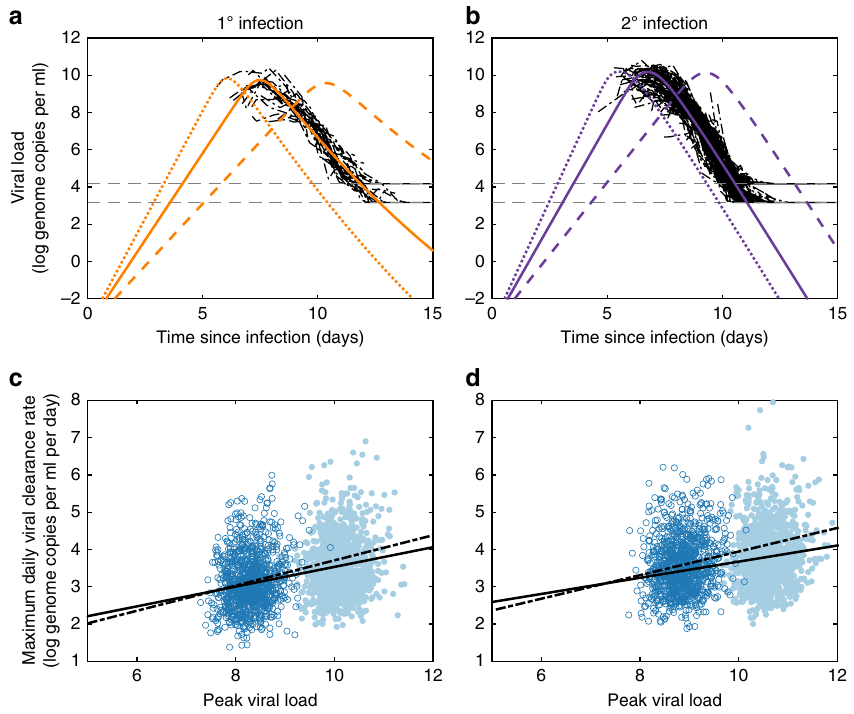
Fig. 2 Within-host model dynamics reproduce empirically observed peak viral load-clearance rate trade-off. a , b Model-simulated viral load dynamics alongside viremia measurements from individuals experiencing a a primary dengue infection and b a secondary dengue infection. Solid colored lines show viral load dynamics parameterized with the mean estimated viral infectivity rate. Dotted lines show viral load dynamics parameterized with a viral infectivity rate two standard deviations above the estimated mean. Dashed lines show viral load dynamics parameterized with a viral infectivity rate two standard deviations below the estimated mean. Viremia measurements are shown in black and are shifted in time based on inferred individual incubation periods using model simulations with mean estimated viral infectivity rates. Viral limits of detection are shown with horizontal gray lines. c Model-simulated peak viral loads and corresponding maximum daily viral clearance rates in primary infections. Filled dots show results from the model parameterized using the full data set (simulated n = 1000). Open dots show results from the model parameterized using the data subset (simulated n